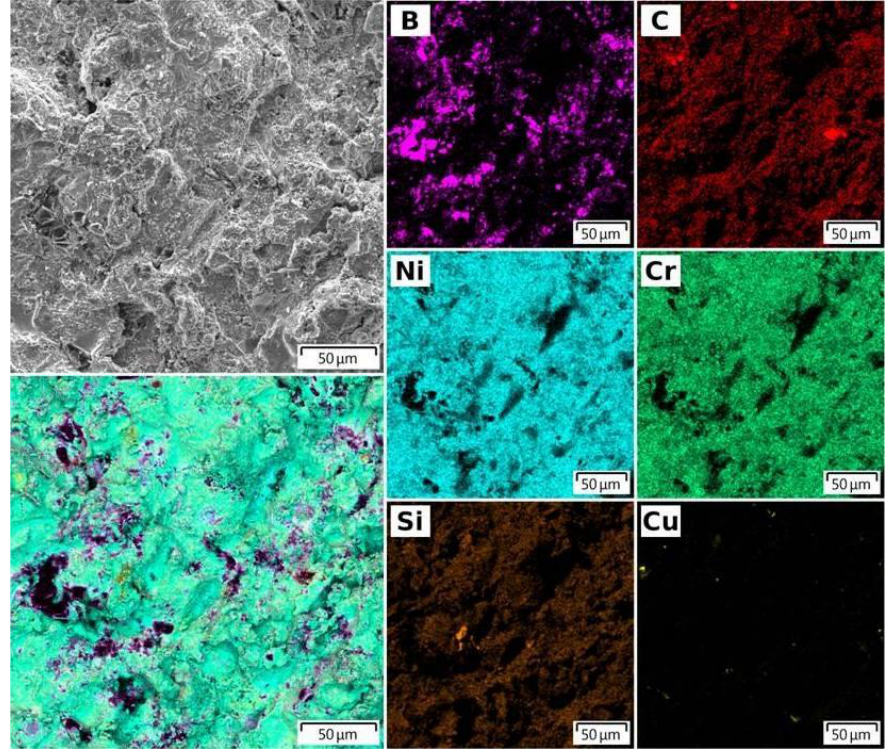
Figure 2. SEM EDX element distribution map of the surface of NiCr-70B 4 C coating on the target surface.